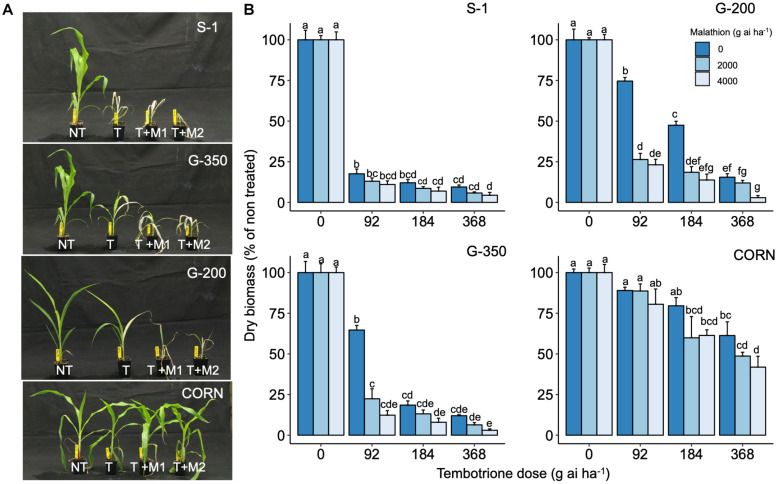
(A) The response of S-1 (susceptible), G-200, G-350 (resistant), and corn to field recommended dose tembotrione (92 g ai ha–1) (T) or malathion treatments (M1: 2,000 g ai ha–1; M2: 4,000 g ai ha–1) followed by field recommended dose tembotrione. NT: non-treated. (B) Above-ground dry biomass of sorghum genotypes when pre-treated with malathion or different doses of tembotrione. The error bars represent the standard error (n = 8); different alphabets indicate a significant difference between treatments (p ≤ 0.05).